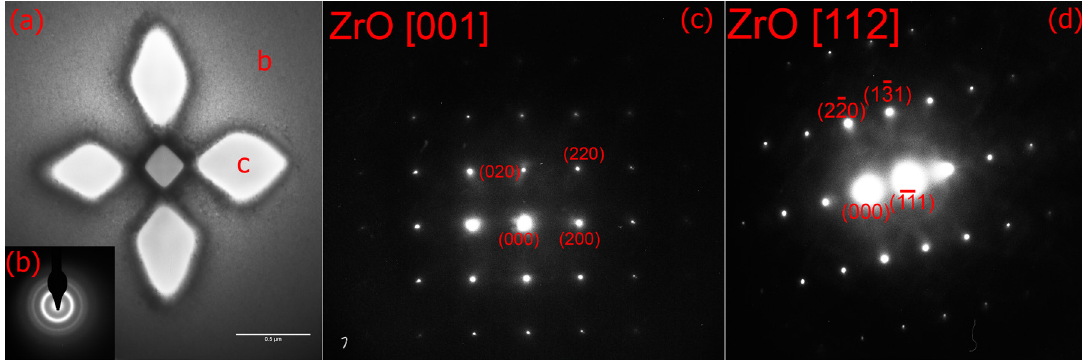
Figure 3. (a) BFTEM image of the amorphous matrix and faceted crystalline phase, (b) SADP from amorphous matrix “b”, (c) [001] SADP from “c”, and (d) [112] SADP from